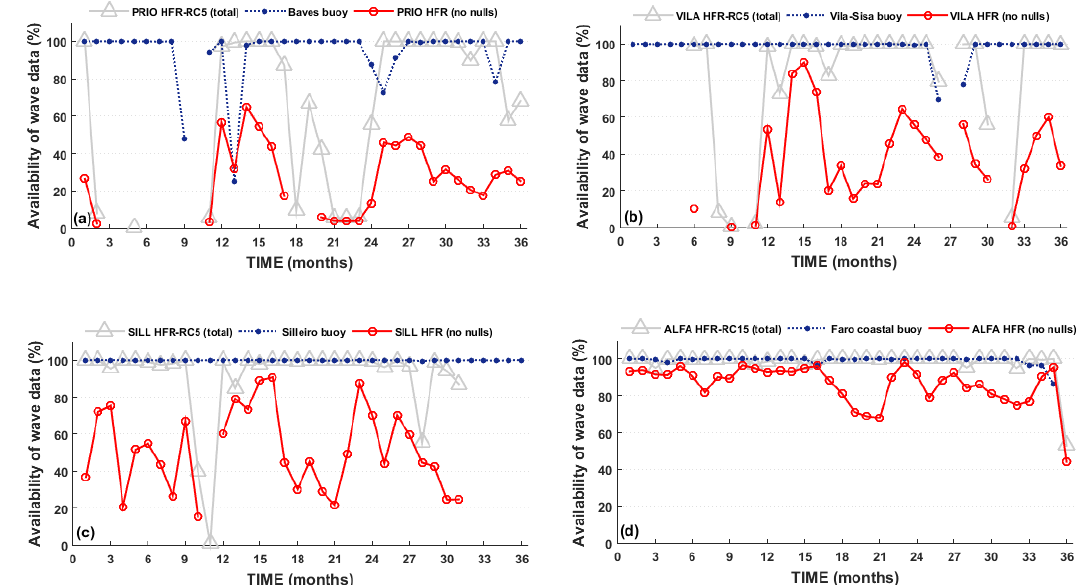
Figure 4. Availability of in situ and matchable HFR wave data during the study period (36 months). ( a ) PRIO HFR (RC-5) / Baves buoy; ( b ) VILA HFR (RC-5) / Villano-Sisargas buoy; ( c ) SILL HFR (RC-5) / Silleiro buoy, and ( d ) ALFA HFR (RC-15) / Faro coastal buoy. Blue dashed lines with dot markers: wave buoy data availability; Grey lines with triangle markers: total HFR wave data availability; red lines with circle markers: HFR wave data availability after excluding the nulls and spurious values.